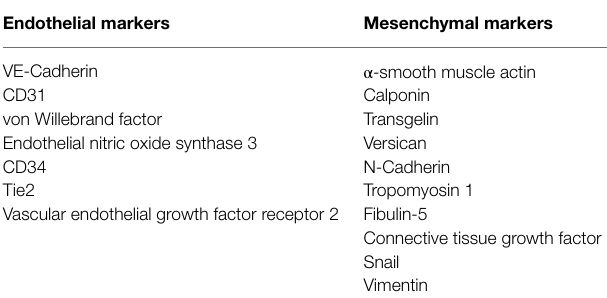
TABLE 1 | Endothelial and mesenchymal